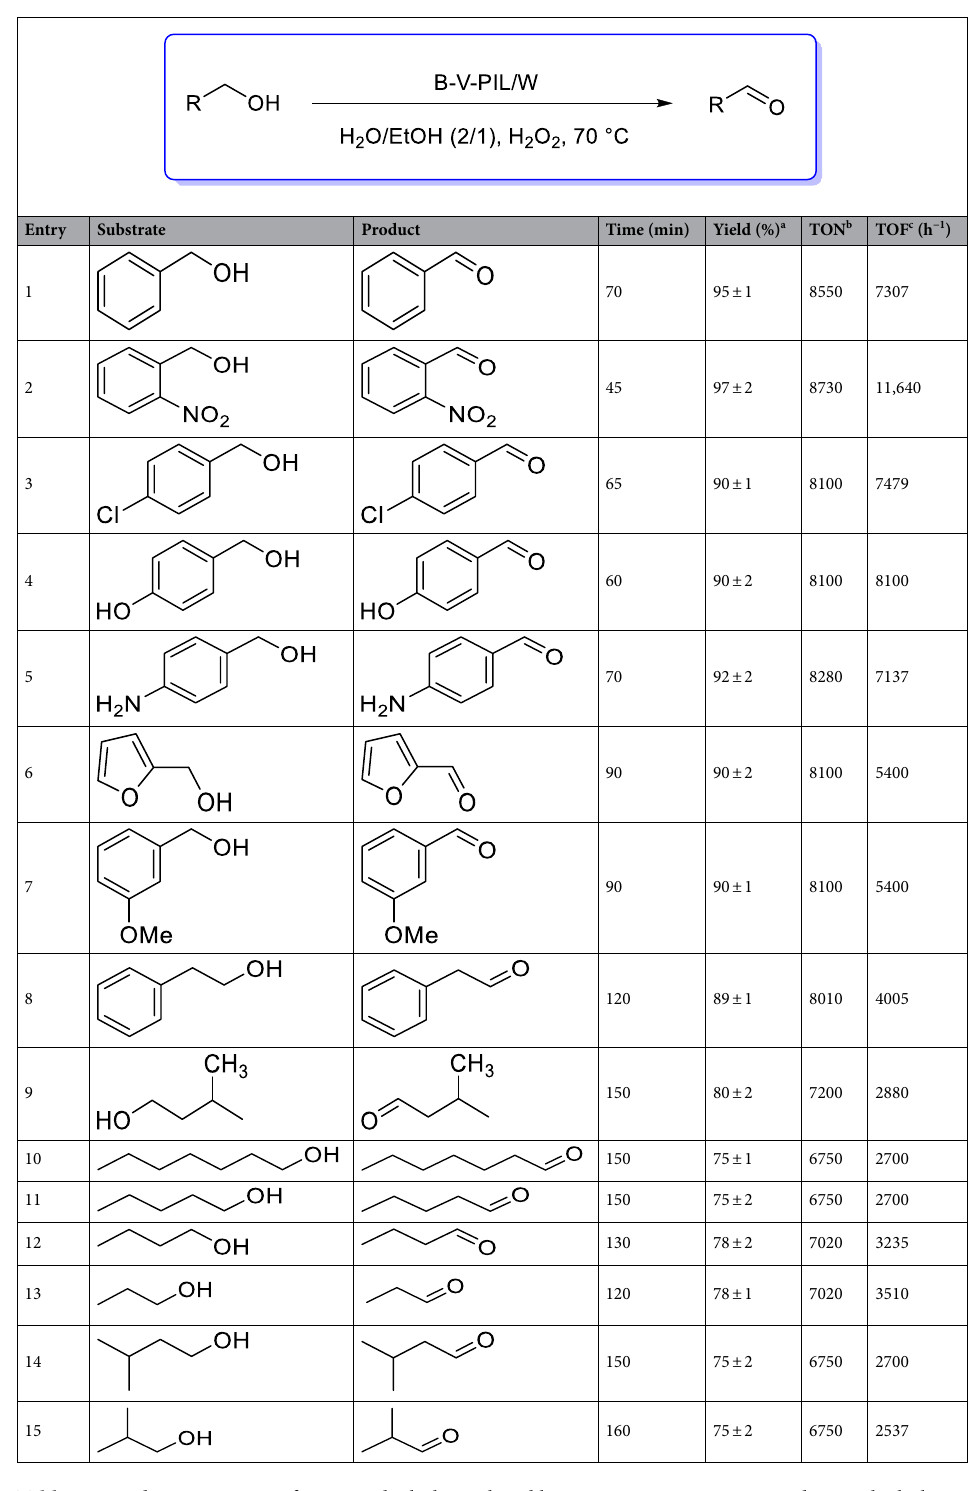
Table 2. Oxidation reaction of various alcohols catalyzed by B-V-PIL/W. Reaction condition: